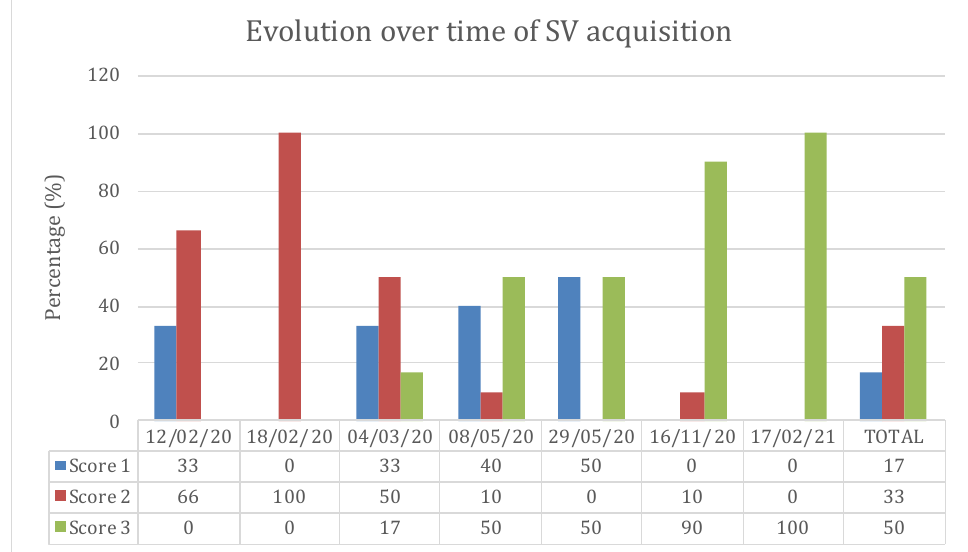
Figure 3. Evolution over time of the percentage (%) of the successful SV cineloop acquisition in calves in the first part of the protocol. Each visit is shown as the completion date (day/month/year). Score 1: No cineloop was recorded because of the impossibility to visualize the CVC on the xyphoid site. Score 2: Cineloop was recorded but the margin of CVC was unclear which made obtaining measurements of the CVC impossible. Score 3: Cineloop was recorded with well-defined margins of the CVC that allowed precise measurements.